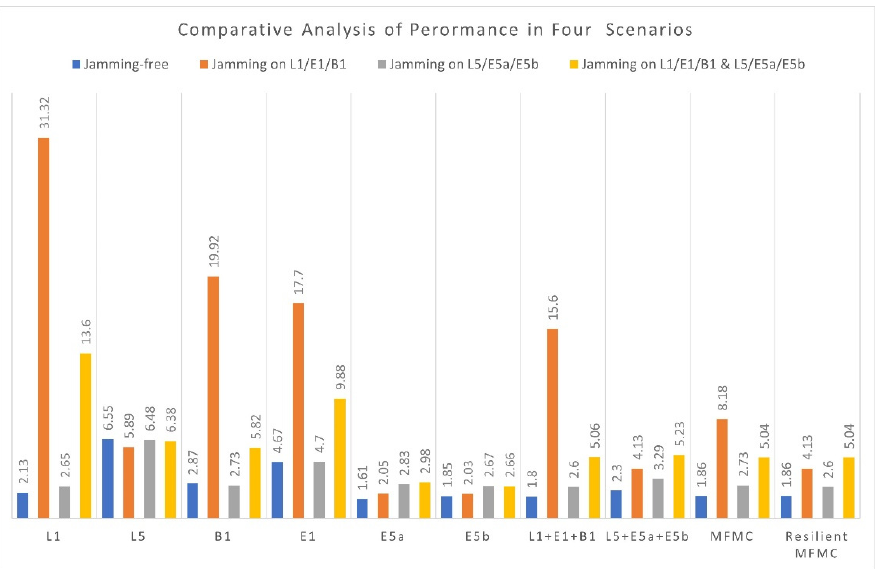
Figure 10. 3D-RMS comparison of different GNSS signals under four scenarios.